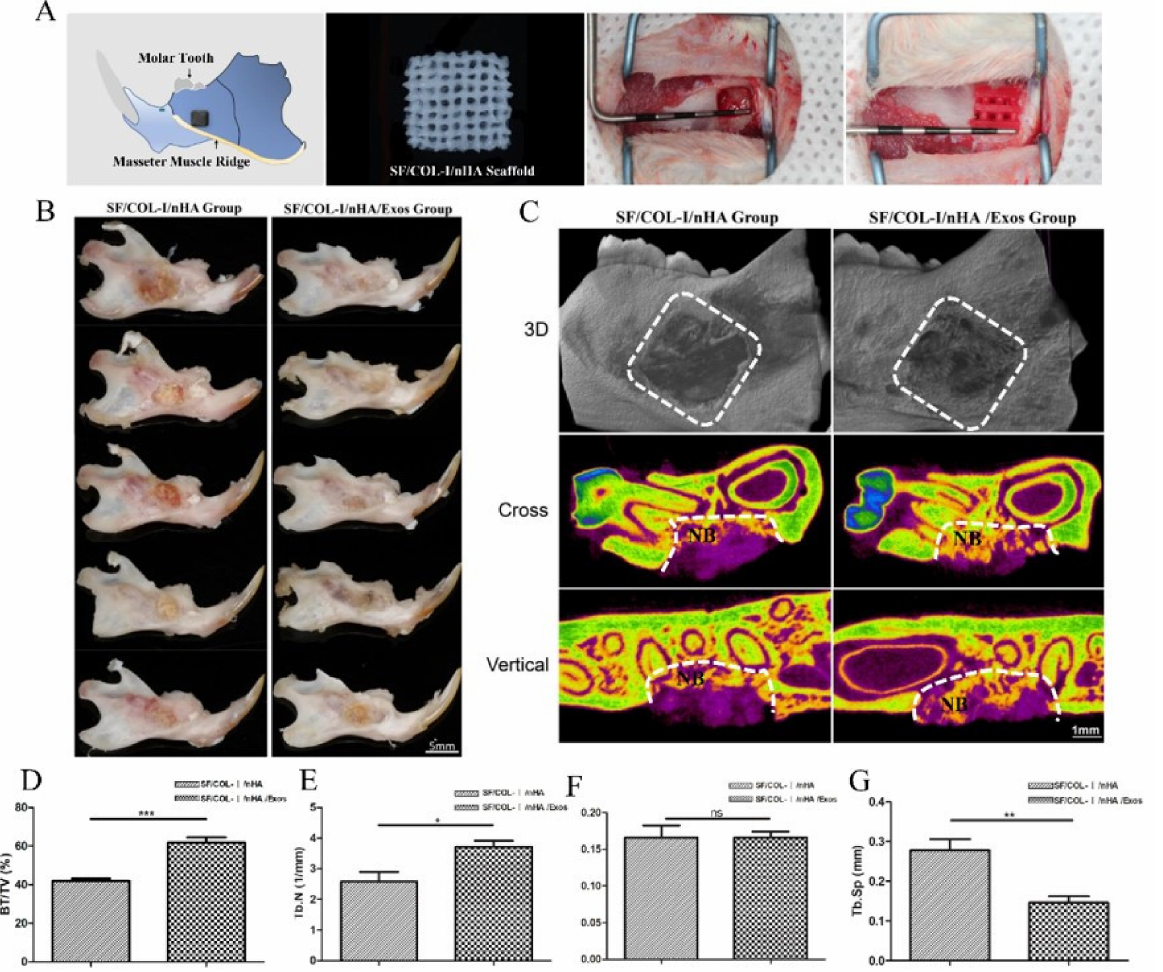
Figure 3. Mandibular defect, reconstruction in vivo, and micro-CT analysis of bone regeneration at 6 weeks. ( A ) Schematic diagram of bone defect model; preparation of defect model; implantation of biomaterials. ( B ) Macroscopic appearance of mandible defect following different treatments. (C) Reconstructed 3D micro-CT images of bone formation; 2D cross-sectional images; 2D sagittal section images. NB: new bone. ( D ) Percentage of new bone formation (BV/TV). ( E ) Trabecular number. ( F ) Trabecular thickness. ( G ) Trabecular separation. Periodontal probe with 2 mm per scale; BV: bone volume; TV: total volume; ns p > 0.05, * p < 0.05, ** p < 0.01, *** p < 0.001, compared with the control